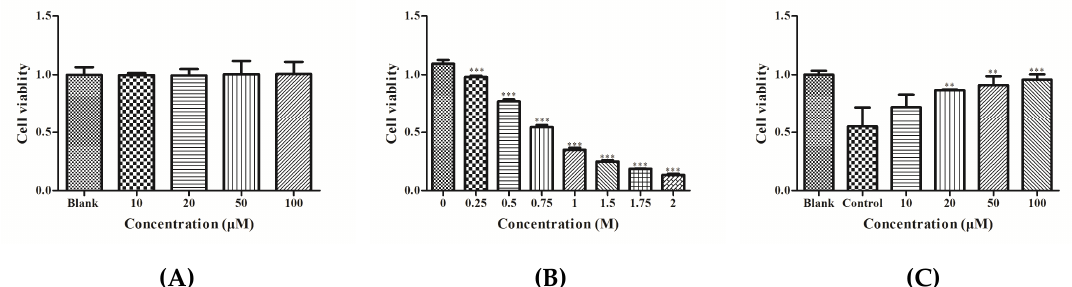
Figure 1. ( A ) The cytotoxic effects of YGDEY on HepG2 cells. Cells were co-cultured with YGDEY (10, 20, 50, and 100 µ M) for 24 h, and cell viability was evaluated by MTT assay. Data are shown as means ± SD ( n = 3). ( B ) Cell viability of ethanol-induced HepG2 cells. Cells were treated with ethanol of different concentrations (0, 0.25, 0.5, 0.75, 1, 1.5, 1.75, and 2 M) for 24 h. Cell viability was evaluated by MTT assay. Data are shown as means ± SD ( n = 3). *** compared with the no-alcohol blank group, p < 0.001. ( C ) Protective effects of YGDEY in HepG2 cells. Cells were pretreated with YGDEY for 24 h prior to treatment with 0.75 M ethanol for 2 h. After the treatment, cell viability was evaluated by MTT assay. Data are shown as means ± SD ( n = 3). ** compared with the control group, p < 0.01. *** compared with the control group, p <